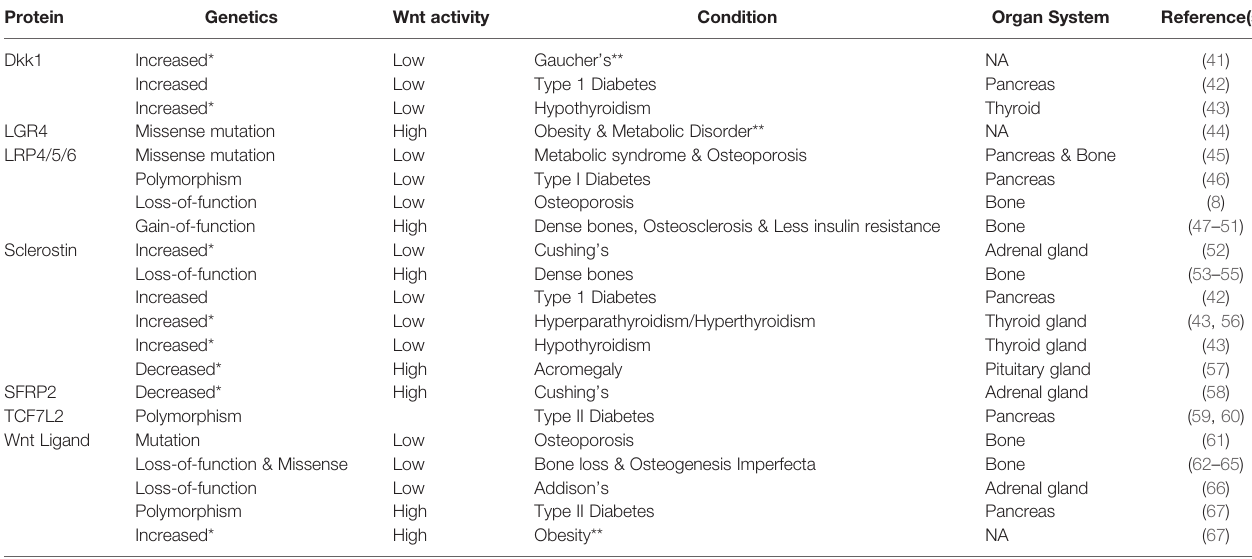
TABLE 1 | Wnt Signaling is Misregulated in Disorders Stemming from Endocrine Systems.